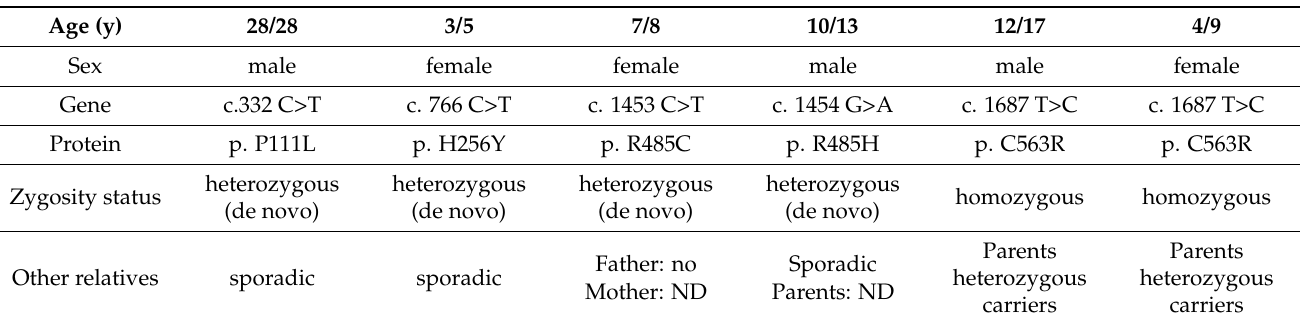
Table 1. Genetic background of PARP6 mutations. Age is shown in years as (age at diagnosis/current age), zygosity is based on allelic variant frequency, ND = not